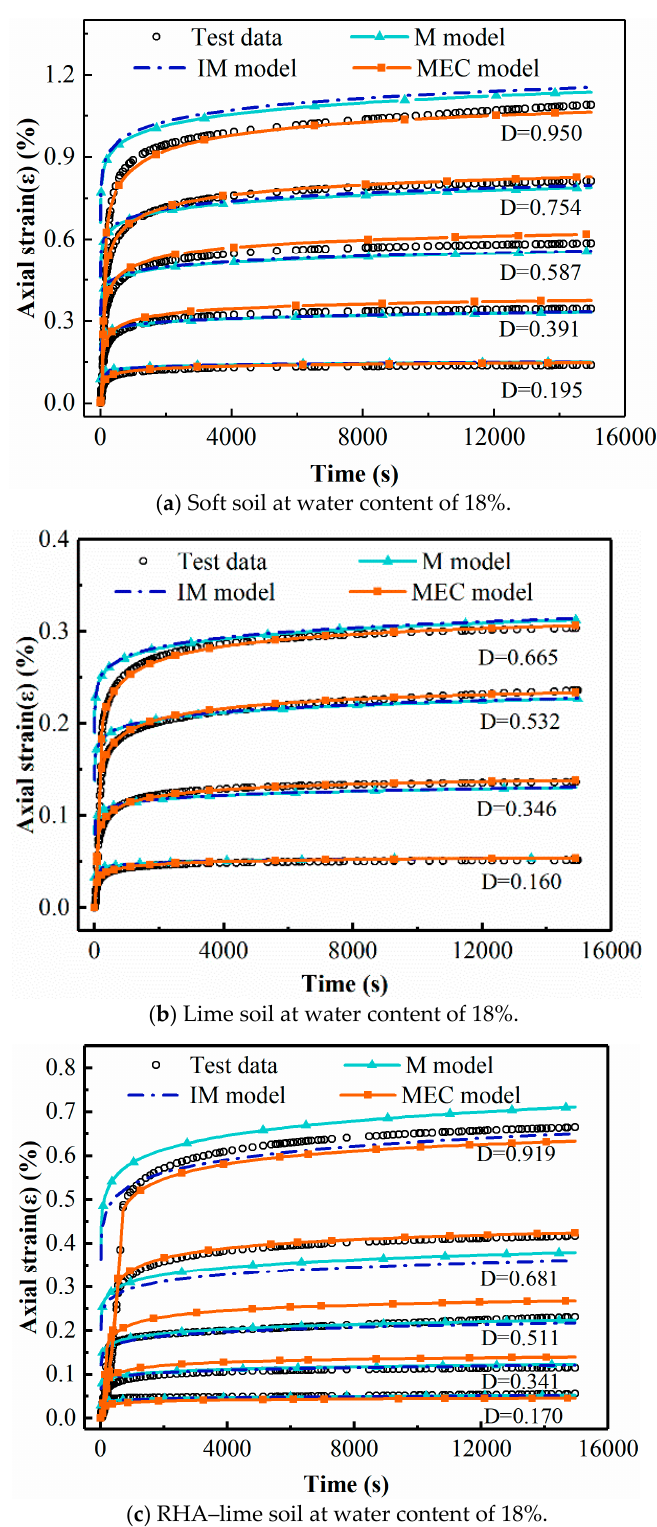
Figure 13. Fitting results of different creep models.